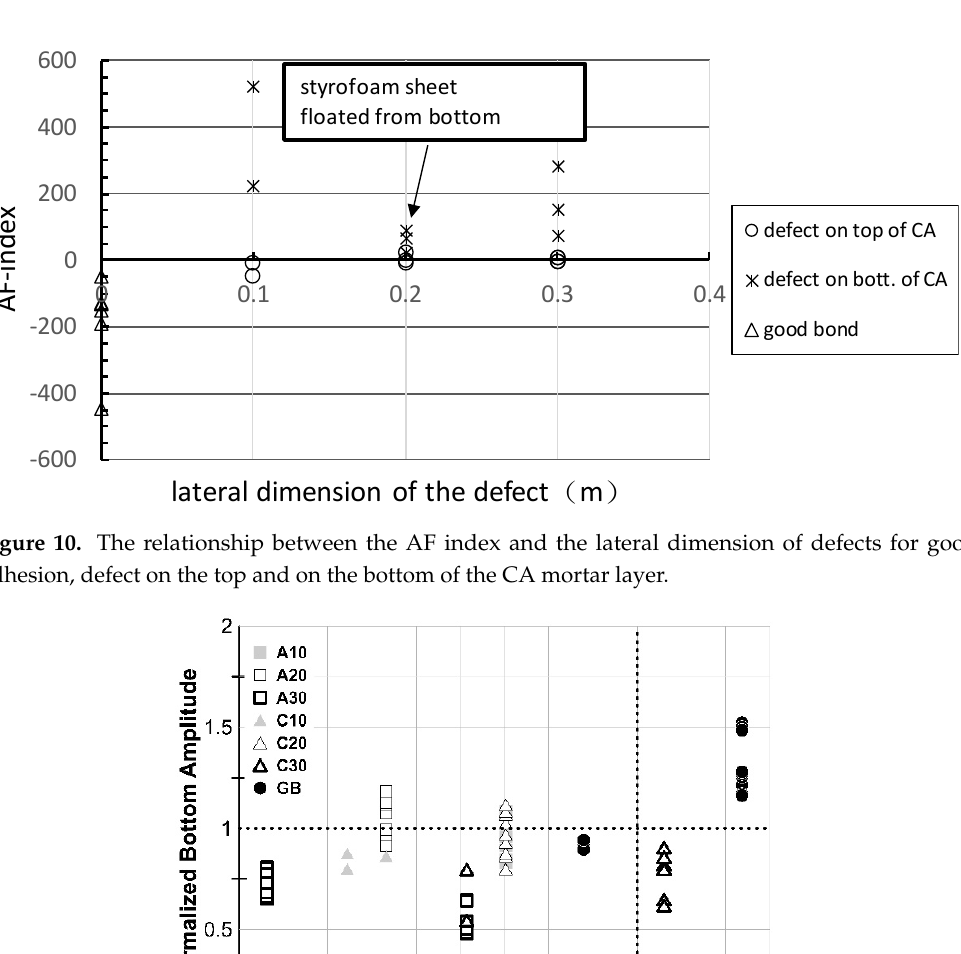
Figure 10. The relationship between the AF index and the lateral dimension of defects for good adhesion, defect on the top and on the bottom of the CA mortar layer.